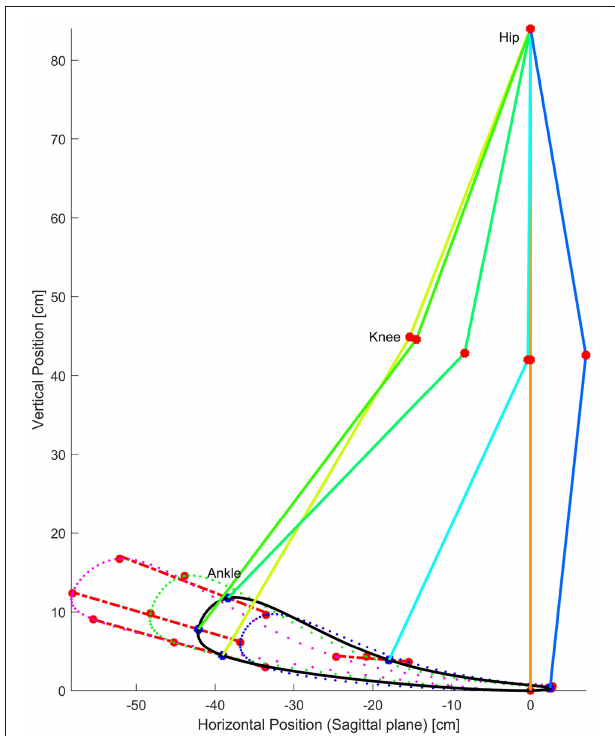
FIGURE 9 | Generated characteristic trajectories in dotted lines for the three trials. Solid line represents the interpolated trajectory proposed for SL = 37[ cm ]. Product of the linear regression between centroids of the same key event, the red lines are used to represent the linear relationship between centroids for the same key event but different test. These lines suggest the use of linear interpolation to predict and set up any intermediate SL for programming a rehabilitation exoskleton as well as assistive devices. Angular position for hip and knee joints are calculated using inverse